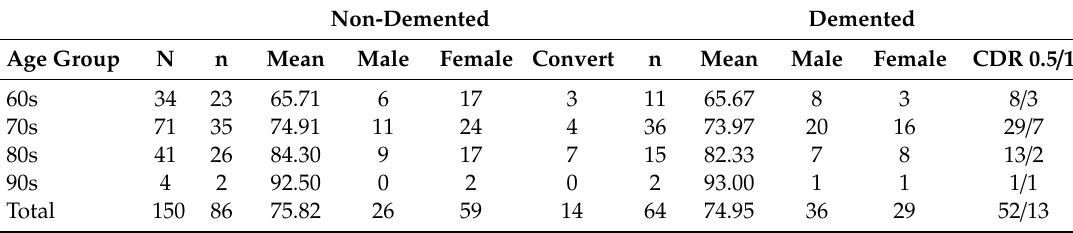
Table 2. Age and characteristics of the individuals investigated on the first clinical visit [18].